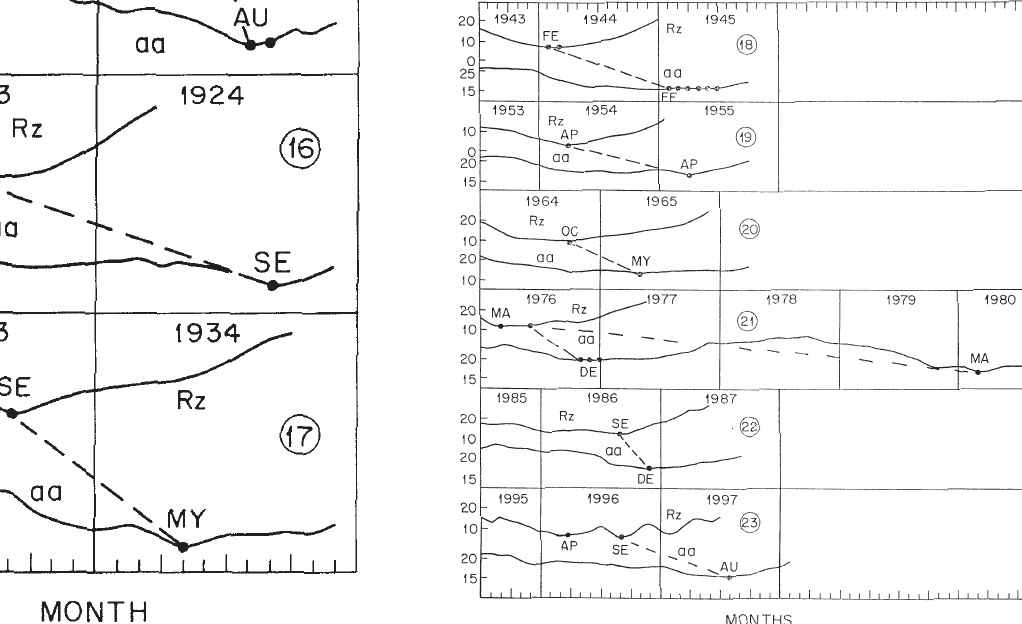
curred in May 1901. However, the aa values were almost flat for several months, so that the aa (min) could be considered as during November 1900 – September 1901. In cycles